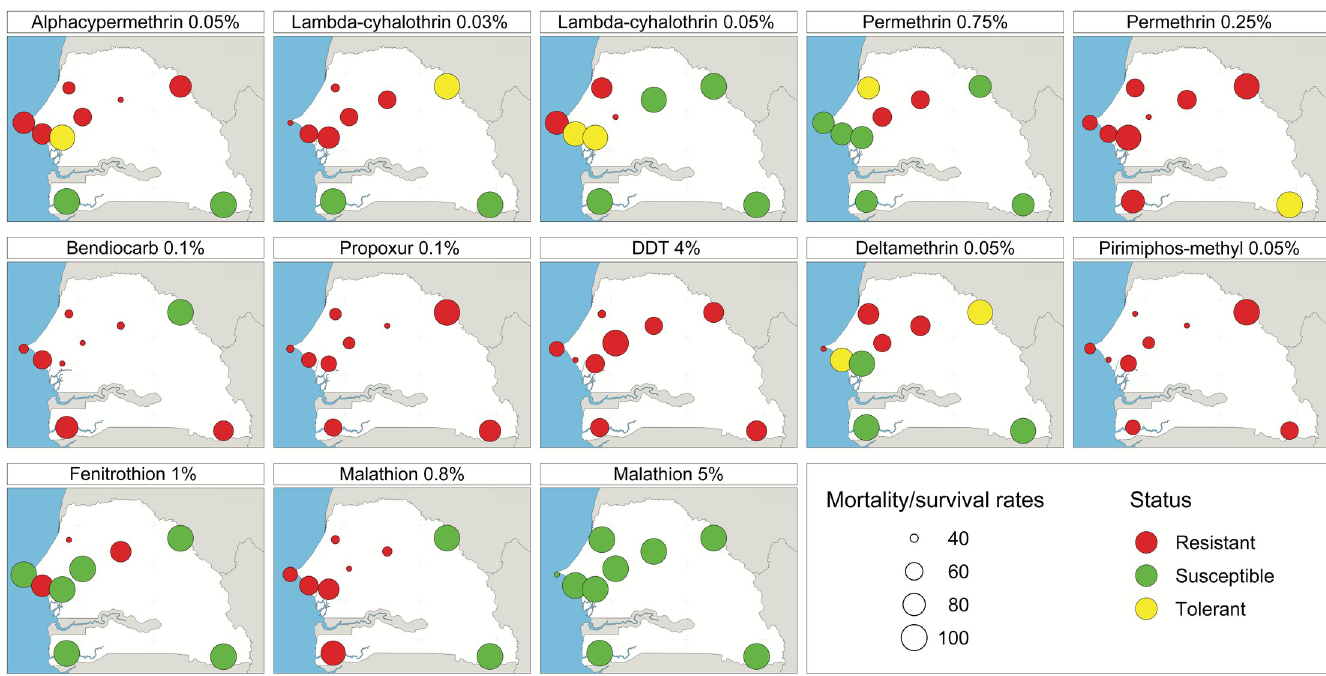
Fig 2. Map showing the resistance status of Ae . aegypti populations, collected from nine localities of Senegal in 2017–2019, to the four classes of insecticides. This map was built using a shapefile from the free domain of the Geographic Information System (http://www.diva-gis.org) with the R software version 3.3.1 and the package map